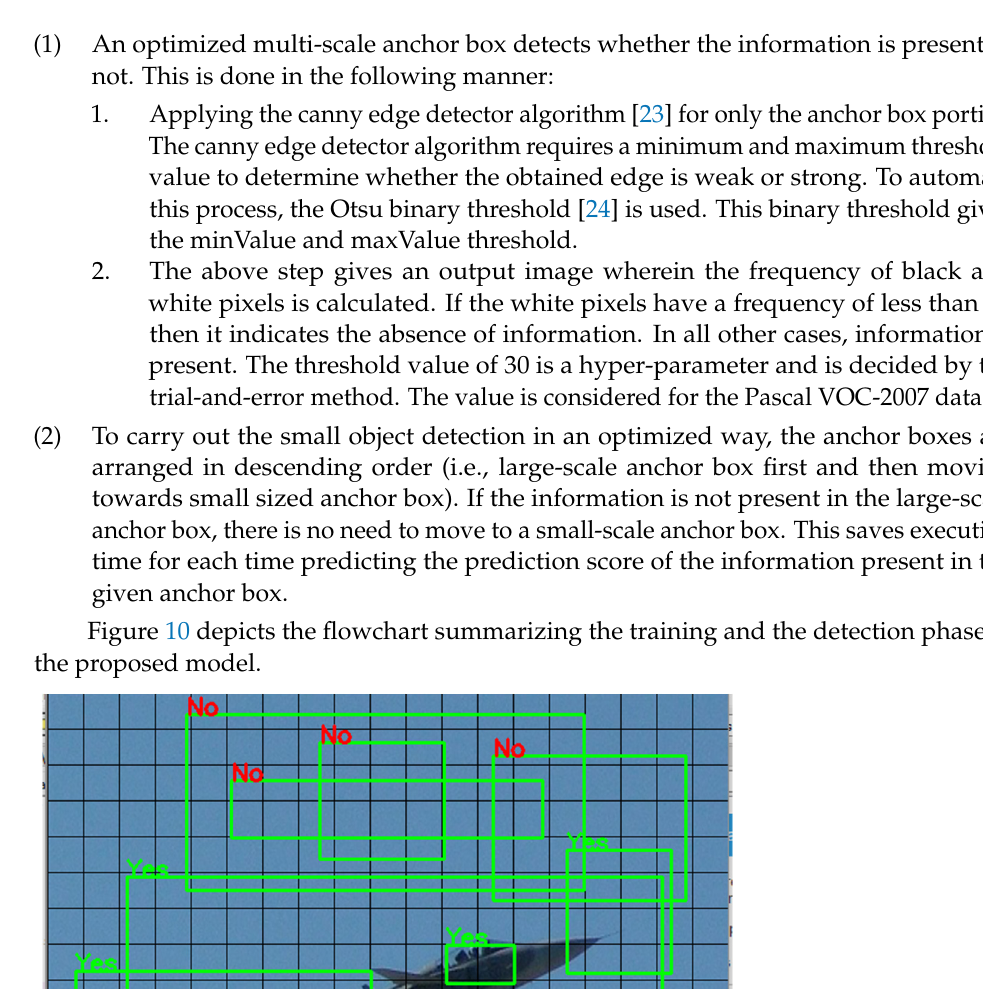
Figure 9. Efficient multi-scale anchor box (Example 2).